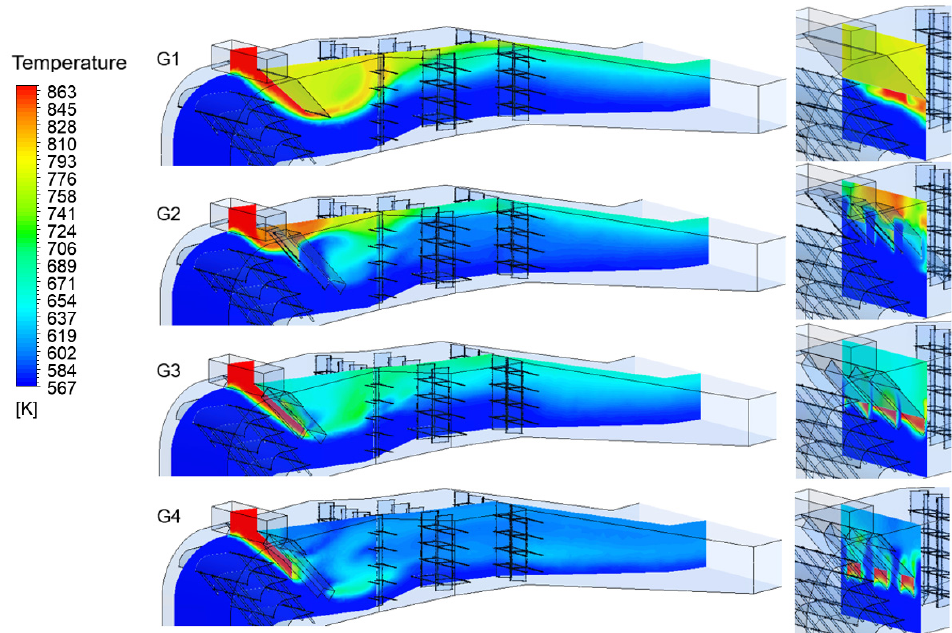
Figure 6. The flue gas temperature distribution for each geometric variant in the plane intersecting the computational domain (on the left) and in the plane perpendicular to the flow direction inter- secting the mixing flap (on the right).